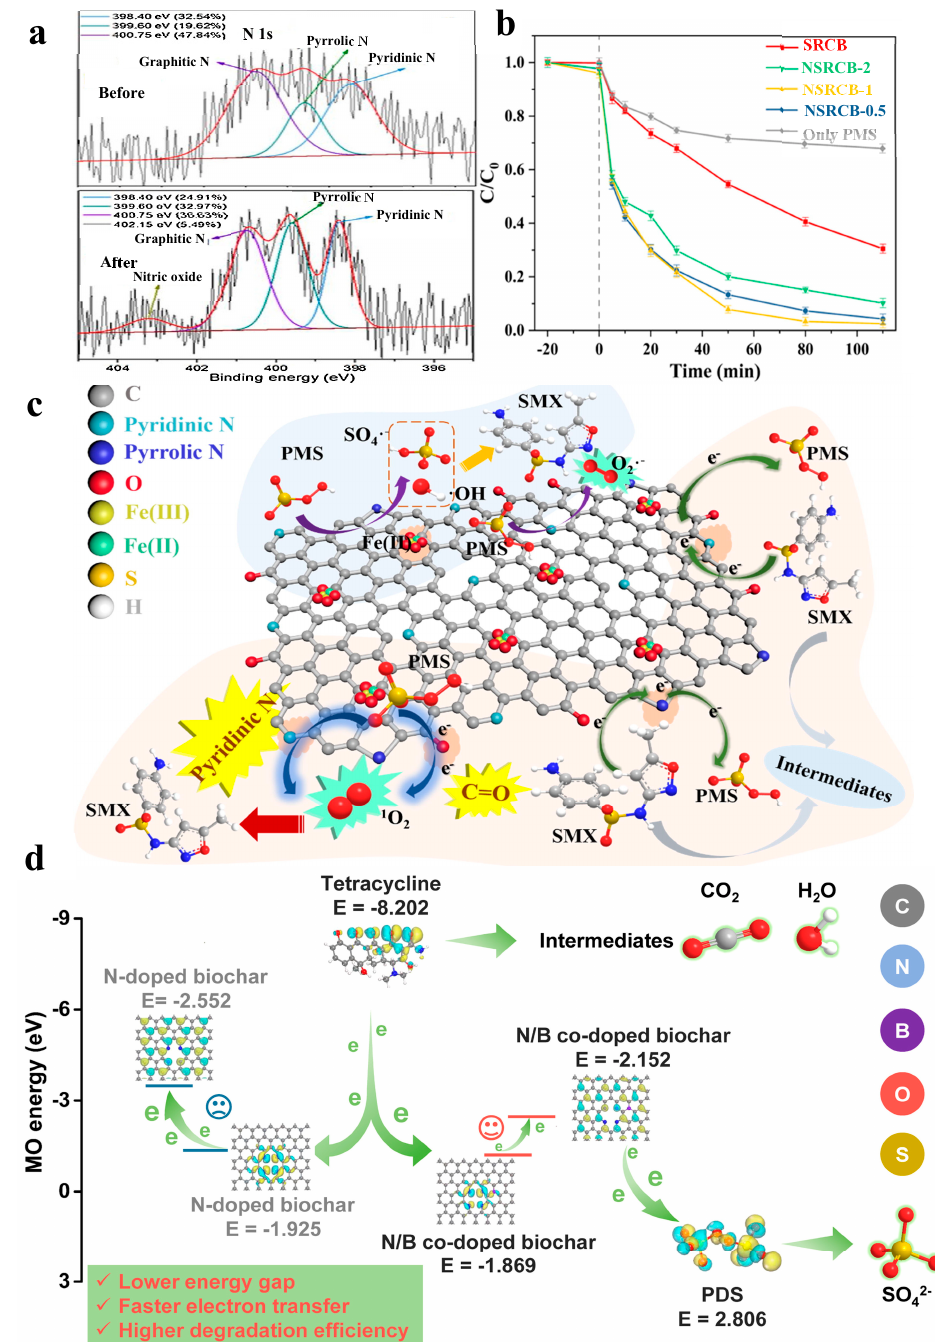
Figure 2. ( a ) High resolution XPS spectrum of N 1s of N – biochar derived from biomass fiber before and after the catalytic reaction. Reproduced with permission from [42]. ( b ) Sulfanilamide degradation by peroxymonosulfate (PMS) activation with biochar materials and ( c ) mechanism scheme. SRCB: sewage sludge – red mud complex biochar. Sulfanilamide: SMX. Reproduced with permission from [40]. ( d ) Electron – transfer pathways driven by different energy gap of biochar materials for tetracycline degradation. Reproduced with permission from [17].